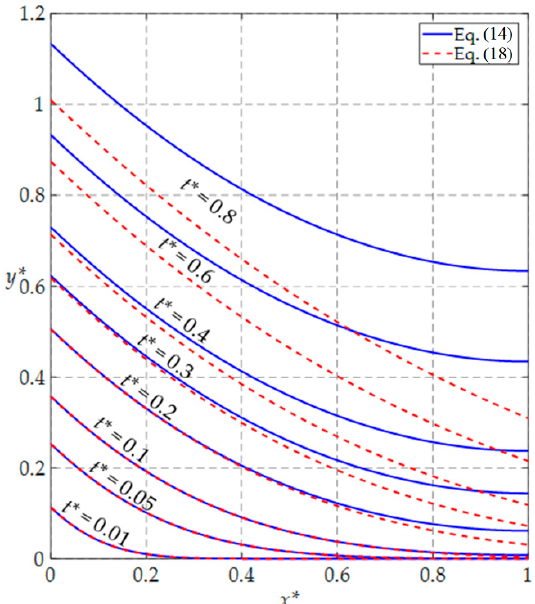
Figure 4. Comparison of shoreline positions calculated by two solutions.